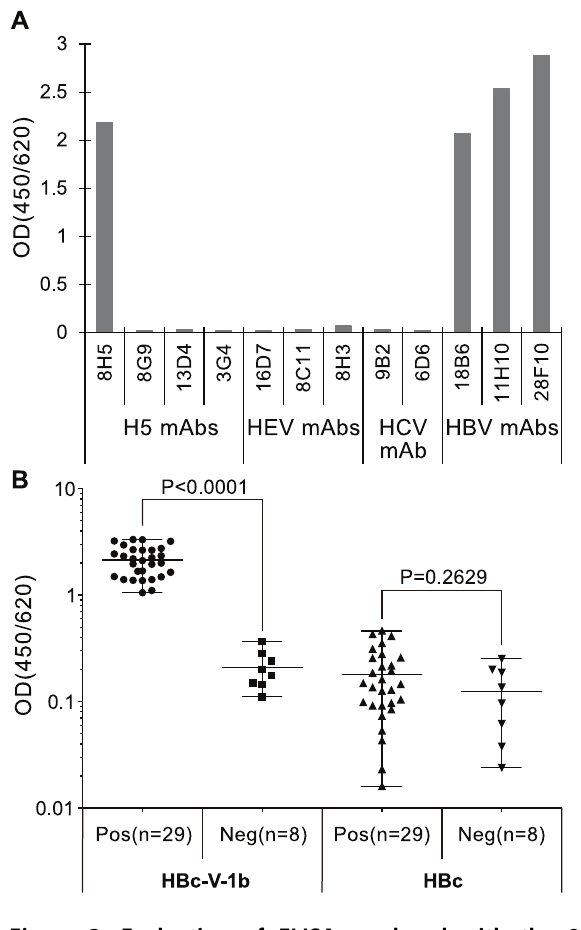
Figure 3. Evaluation of ELISA produced with the 8H5 reactive12mer peptide (V-1b). In the top panel, microplates were coated with V-1b-HB core antigen (HBc-V-1b) were reacted with monoclonal antibodies specific for H5 molecule of H5N1 avian influenza virus (H5 mAbs), hepatitis E virus (HEV mAbs), hepatitis C virus (HCV mAb) and monoclonal antibodies specific for the HBV core antigen (HBV mAbs). In the bottom panel, these and also microplates coated with HBc alone were reacted with serum samples from 29 chicken infected with the H5N1 avian influenza virus and 8 control uninfected animals.